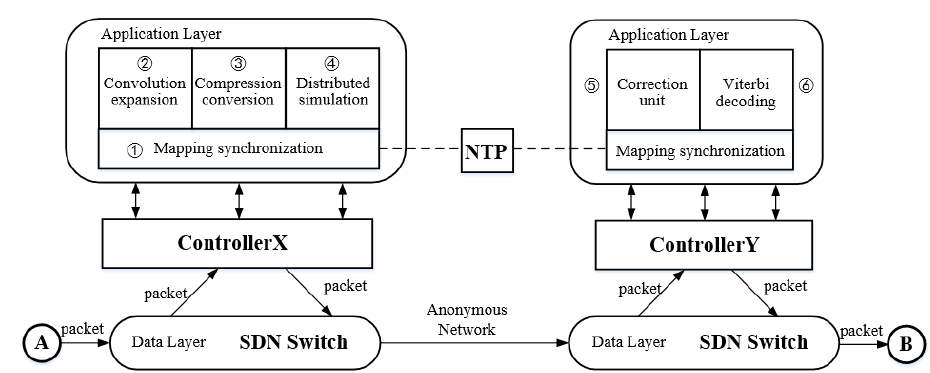
Figure 5. Application Components of SACT.